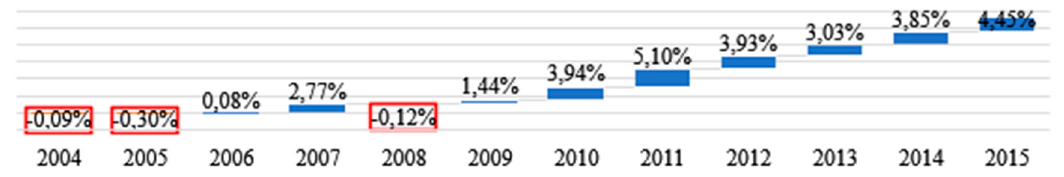
Figure 1. Growth dynamics of joint-stock companies in Poland. Source: Own figure based on Central Statistical Office (GUS) data.